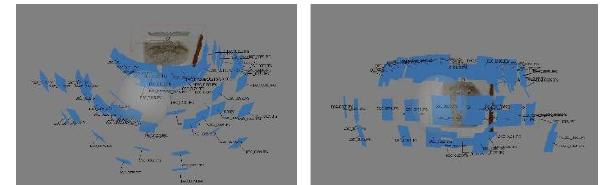
Figure 2. Data set in Photoscan for 3D processing